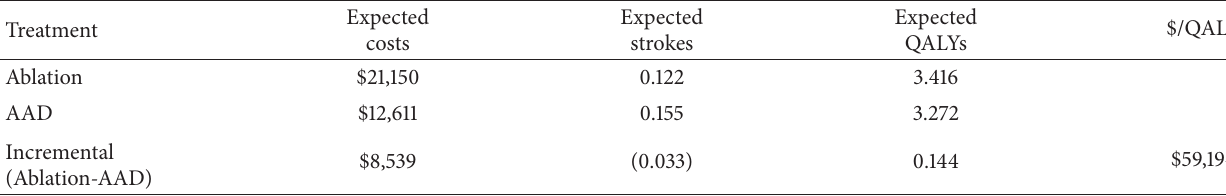
Table 3: Basecase cost-effectiveness results.